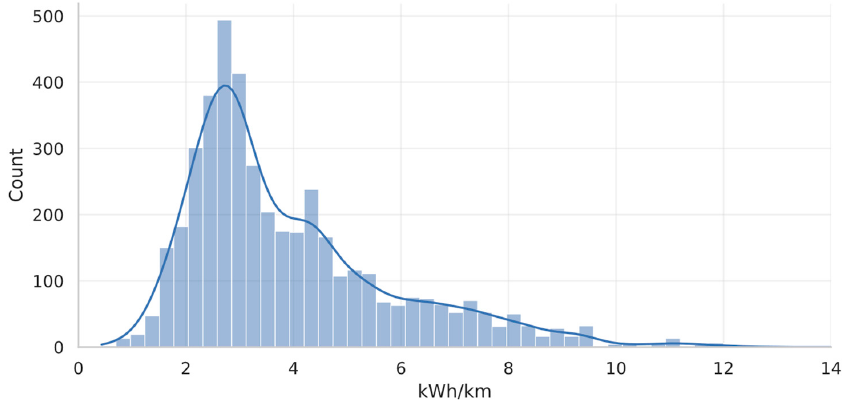
Figure 4. Distribution of energy consumption for various bus lines.